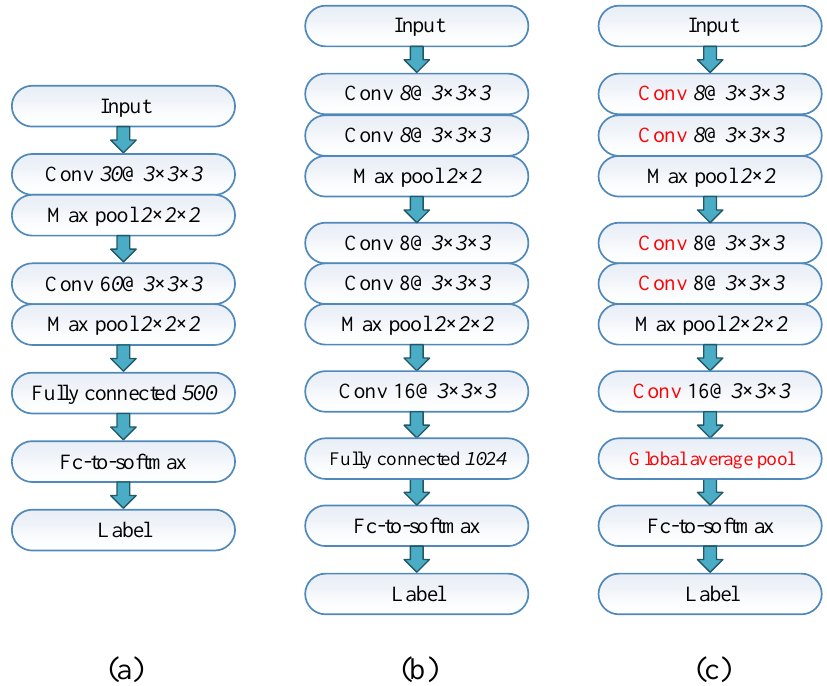
Figure 6. 3D architectures for PolSAR image classification. ( a ) The architecture of 3D-convoluted neural networks (CNN) proposed by [31]. ( b ) The updated version of 3D-CNN in this paper. ( c ) The proposed 3D-CNN framework with lightweight 3D convolutions and global average